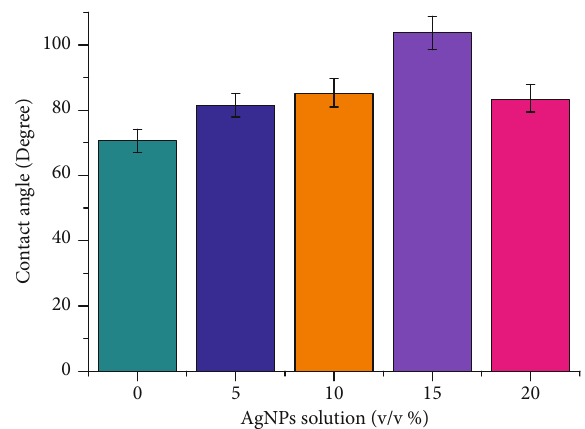
Figure 3: E ff ect of AgNP solution on the hydrophilicity of the fi lms.